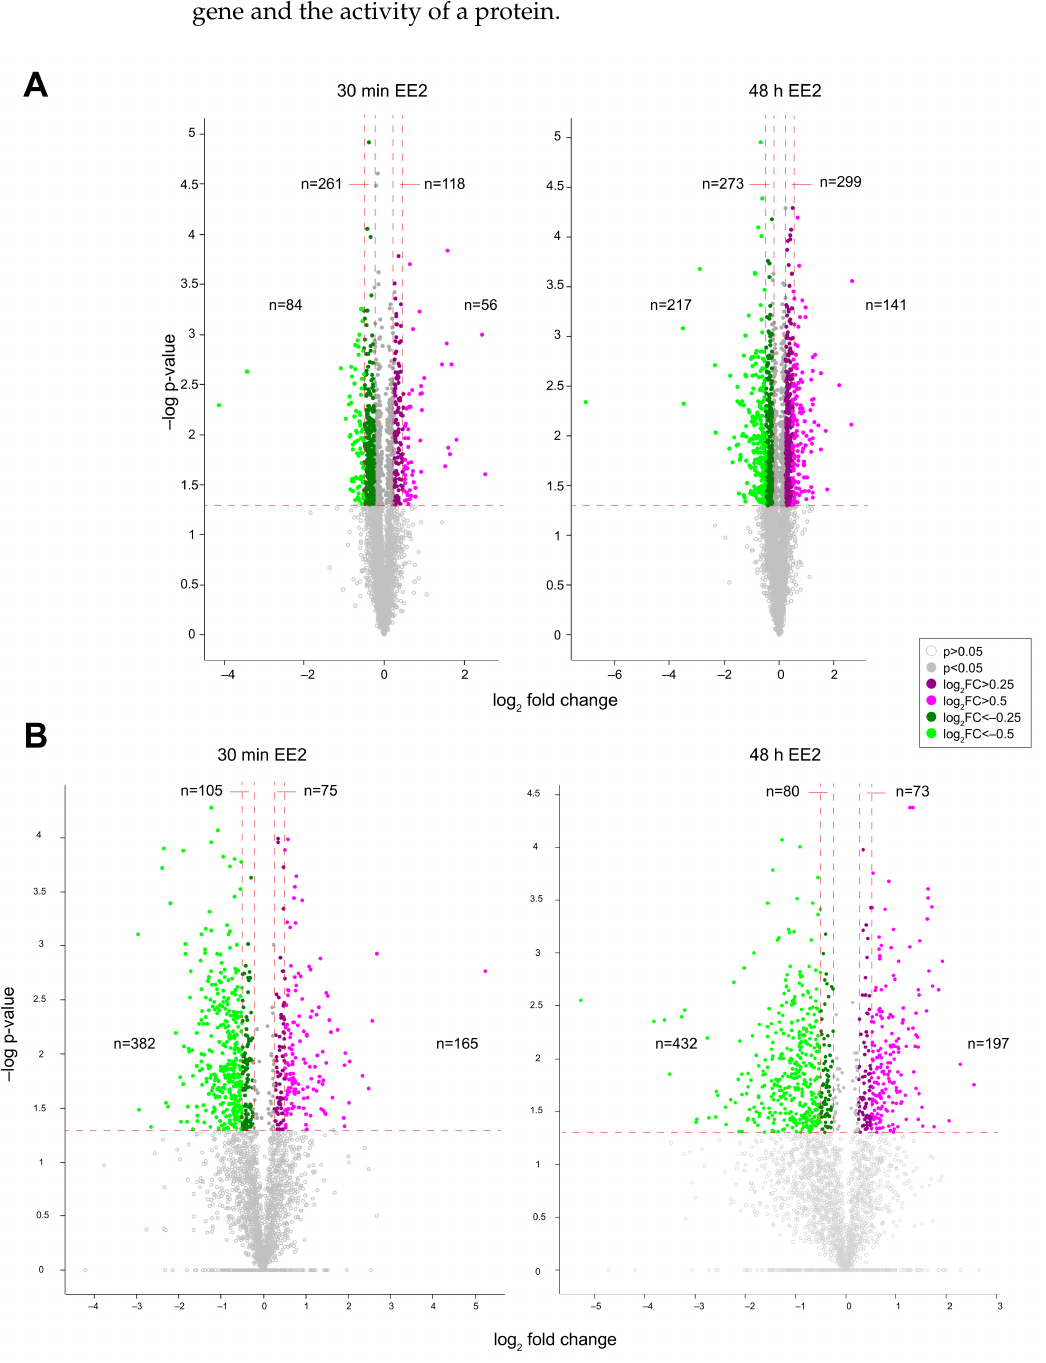
Figure 1. Volcano plots of proteomic ( A ) and phosphoproteomic ( B ) changes following 100 nM EE2 for 30 min or 48 h. p = 0.05 is indicated by the horizontal dotted red line, open circle plot points are non-significant ( p > 0.05) and closed circle plot points are significant ( p < 0.05). The log 2 fold change (FC) is indicated by the colour of plot points, vertical dotted red lines indicate 0.25 and 0.5 log 2 FC. Purple = log 2 FC > 0.25, pink = log 2 FC > 0.5, dark green = log 2 FC < − 0.25, green = log 2 FC < −